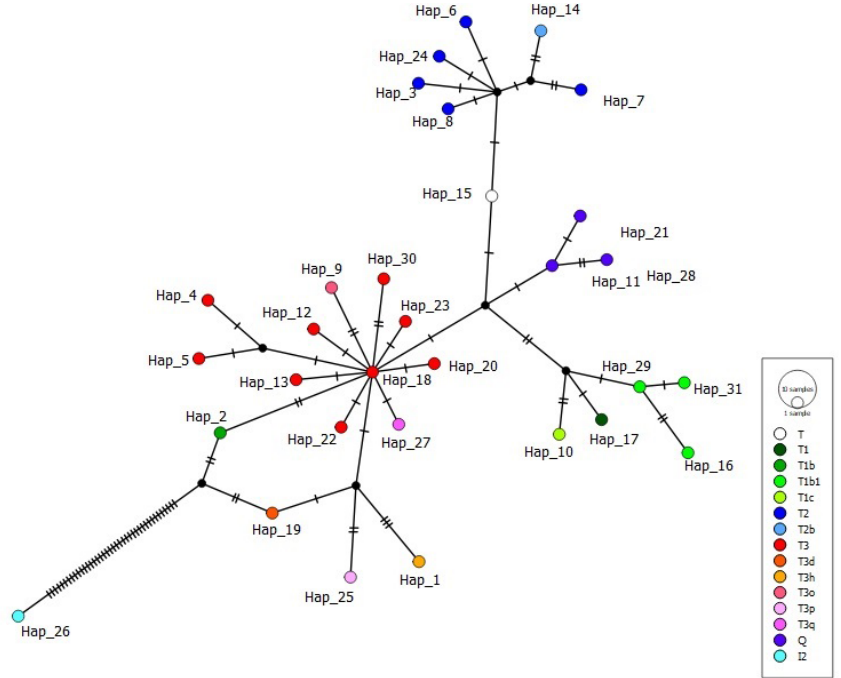
Figure 1. Median joining network of 31 haplotypes detected in three native Turkish cattle breeds based on 897bp mtDNA D-loop region sequences (colours in circles indicate haplogroup